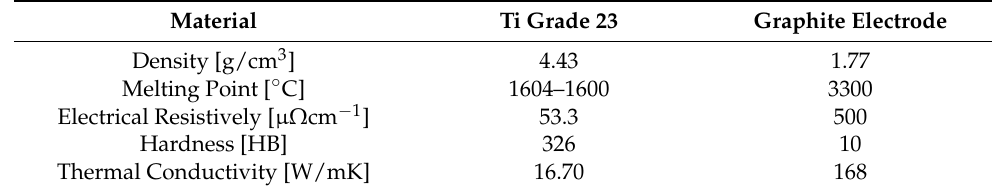
Table 2. Chemical composition of Ti-6Al-4V ELI.